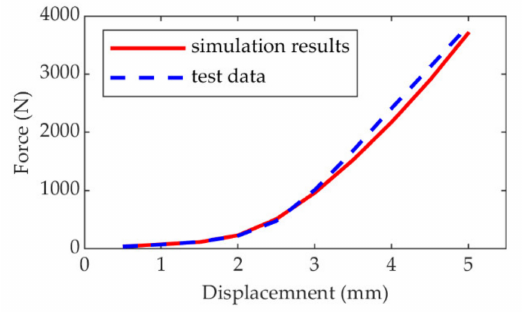
Figure 16. Comparation with test results and numerical simulation